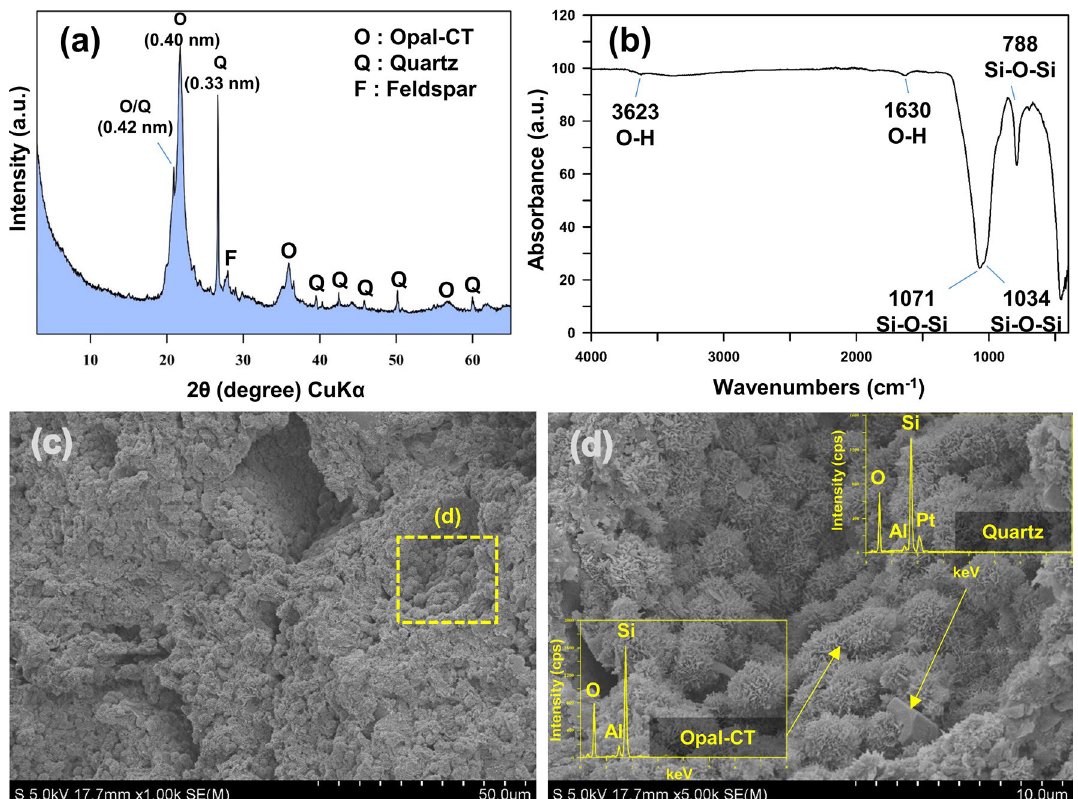
Figure 1. ( a ) XRD, (b) FT-IR, and ( c , d ) SEM–EDS analyses of the opaline mudstone.